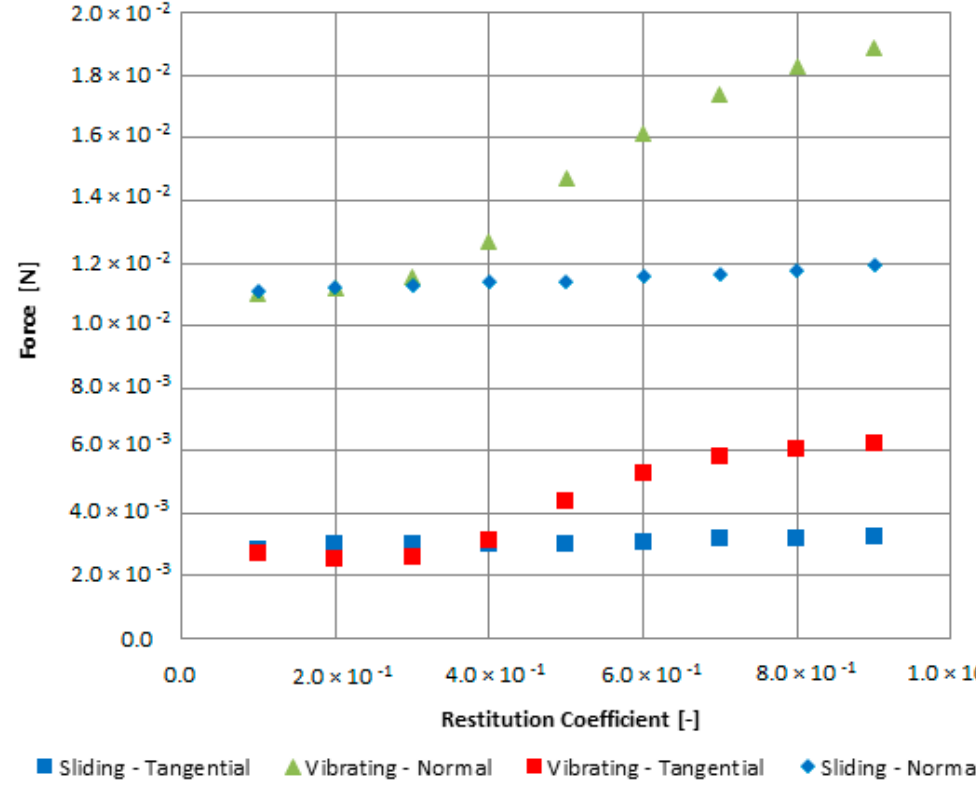
Figure 13. Values of the restitution coefficient of blueberry fruit during transport on a trough with vibrating motion and a trough with reciprocal motion.